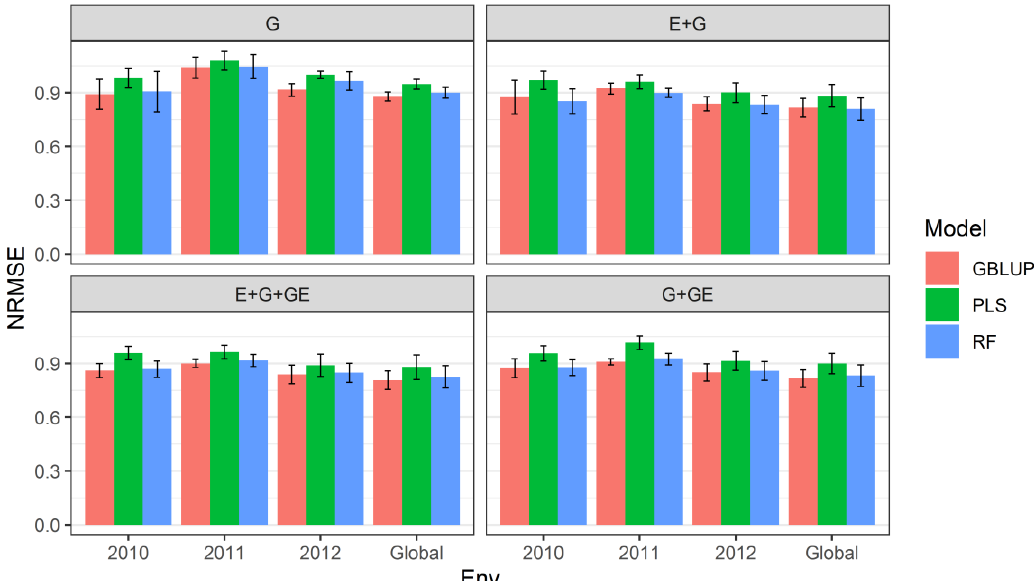
Figure 1. Prediction performance for each environment and across environments (Global) of dataset 1 (Indica) in terms of normalized mean square error (NRMSE) under four predictors (G, genotypic information; E + G. environment plus genotypic information; E + G + GE, environment plus genotypic plus genotype by environment interaction information; and G + GE, genotypic plus genotype by environment interaction) and under the sevenfold cross-validation (CV) scheme. Table 1. Variance components (variance) and heritability estimates for dataset 1 ( Indica ) for each trait. CV denotes coefficient of variation, and Locs denotes the average number of locations.